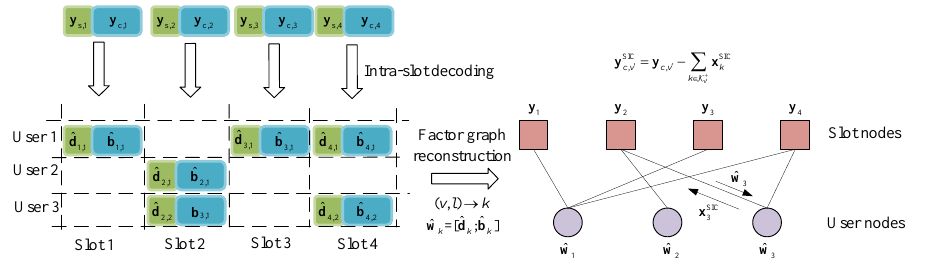
Figure 4. An example for inter-slot factor graph reconstruction and SIC process, where K a = 3 and V =